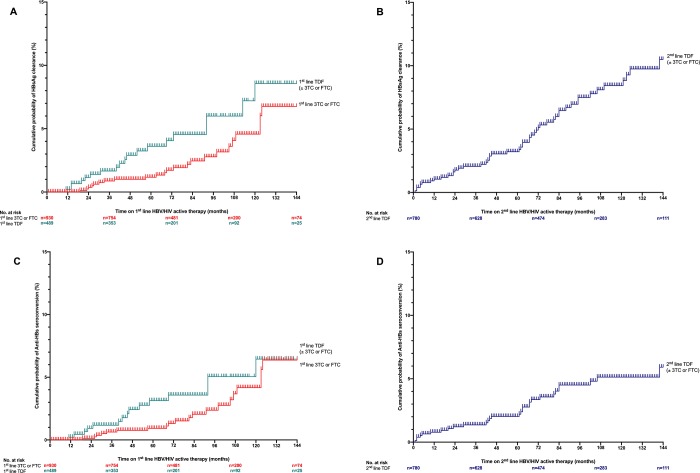
Kaplan-Meier analysis of HBsAg clearance and anti-HBs seroconversion.Kaplan-Meier analysis of HBsAg clearance on 1st line regimen (A): 3TC or FTC-based regimen (n = 930, corresponding to the addition of the follow-up of individuals who only received FTC or 3TC [n = 150], plus the first part of the follow-up of those who then switched to TDF containing regimen [780]), or TDF with or without 3TC or FTC-based regimen (n = 489); and 2nd line regimen (B): TDF with or without 3TC or FTC-based regimen (n = 780, corresponding to the second part of the follow-up of those who first received 3TC or FTC and then TDF). The corresponding Kaplan-Meier analyses of Anti-HBs seroconversion are depicted in (C) for 1st line regimen and (D) for 2nd line regimen. TDF, Tenofovir disoproxil fumarate; 3TC, lamivudine; FTC, emtricitabine.